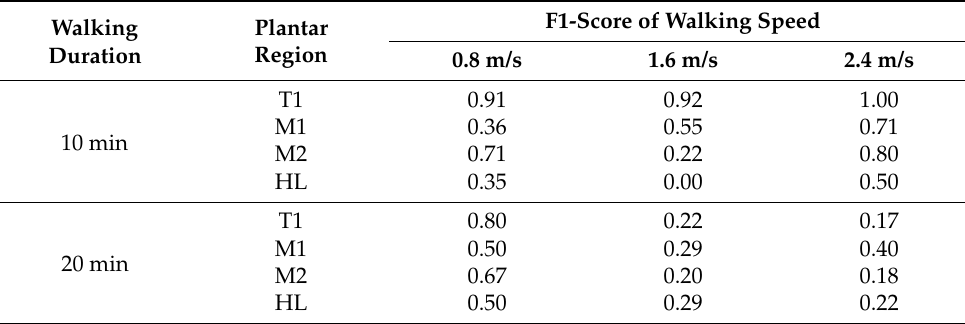
Table 1. Effect of walking speed on the F1-score in four plantar regions.